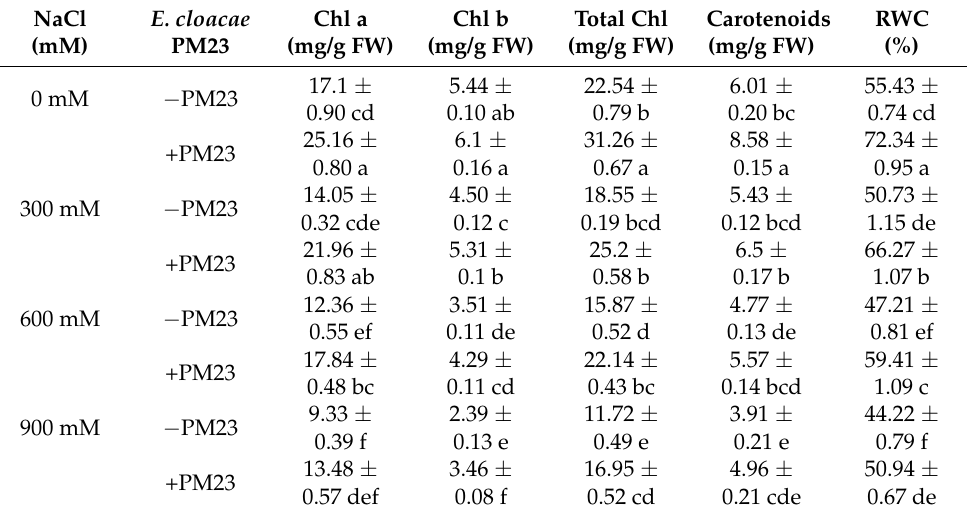
Table 3. Influences of E. cloacae PM23 on chlorophyll a, b, total chlorophyll, carotenoids and relative water content in leaves under salinity stress.